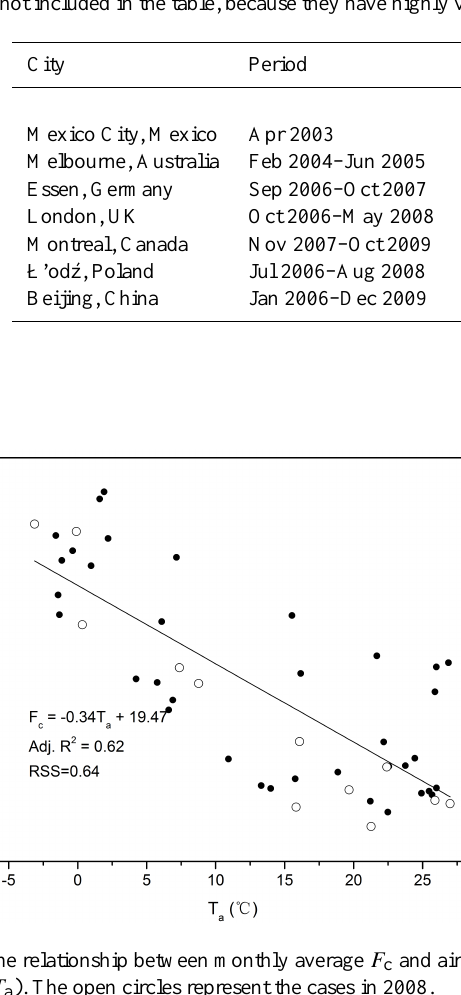
Fig. 9. Monthly average F c calculated from non-gap-filled dataset and monthly average air temperature ( T a ). The error bars indicate one standard deviation. Table 3. Net annual carbon dioxide flux at urban sites around the world. The sites were selected for comparison based on two criteria: (1) annual CO 2 emission was estimated; (2) the environment around the site was highly urbanized. The Mexico site was analyzed by Velasco et al. (2005) using one month data, but the author rudely estimated the annual value, and this site was included in the comparison. The suburban sites were not included in the table, because they have highly vegetation cover and CO 2 emissions were usually much lower than urban sites.